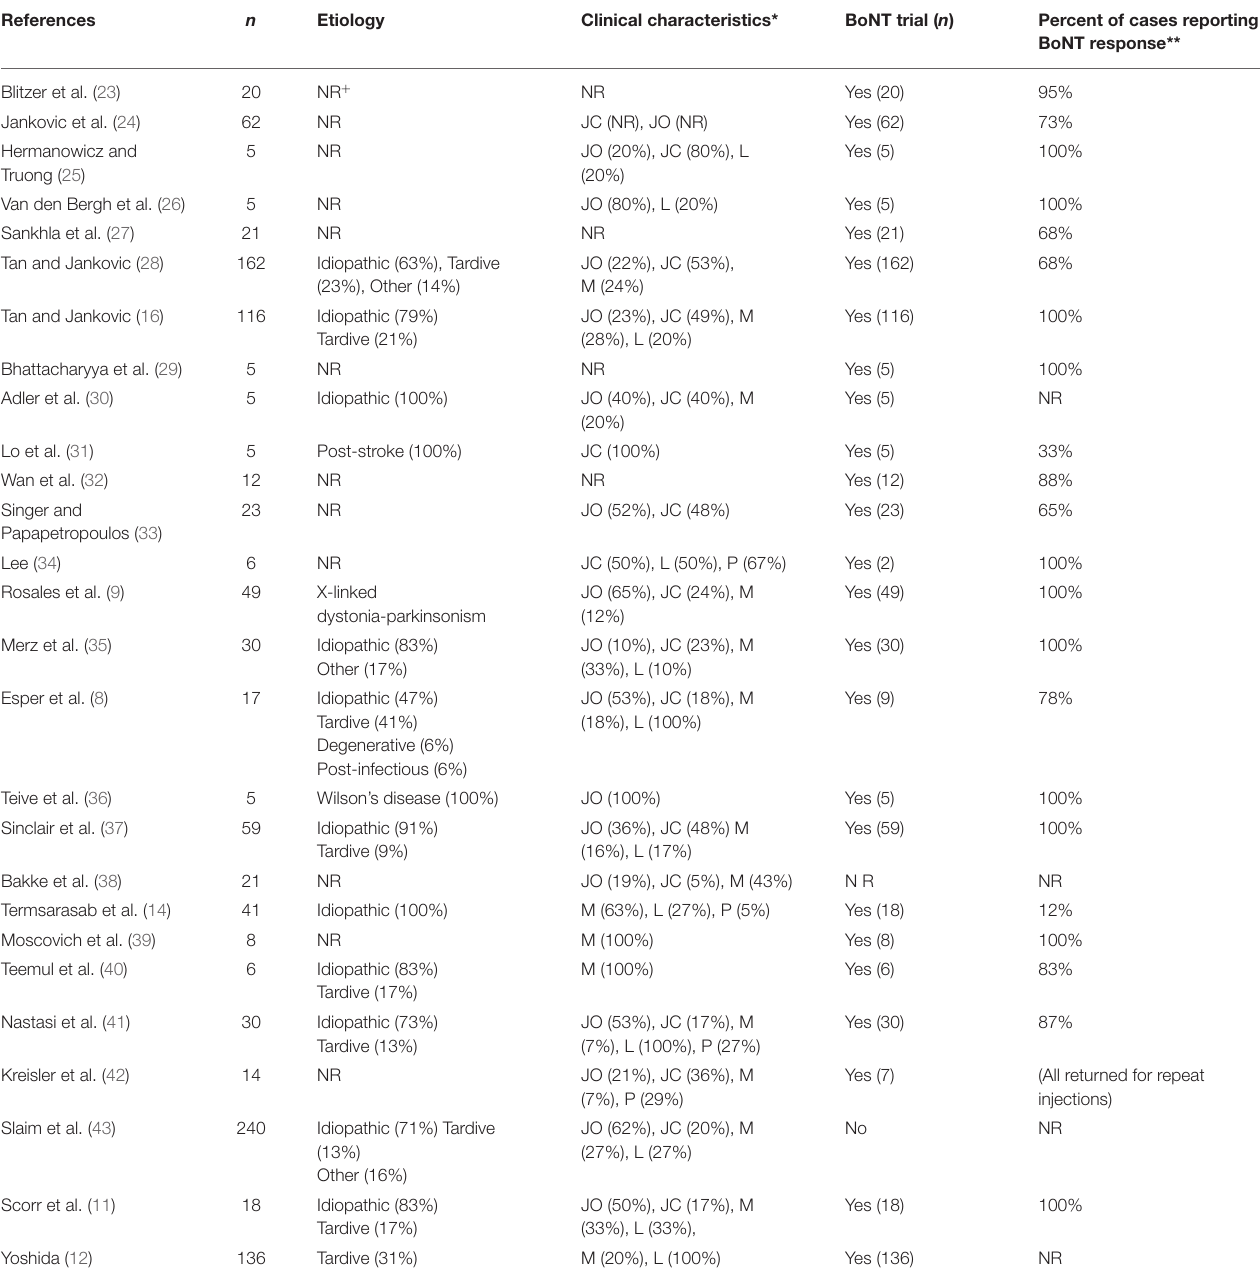
TABLE 1 | Clinical characteristics of 1,121 published cases of oromandibular